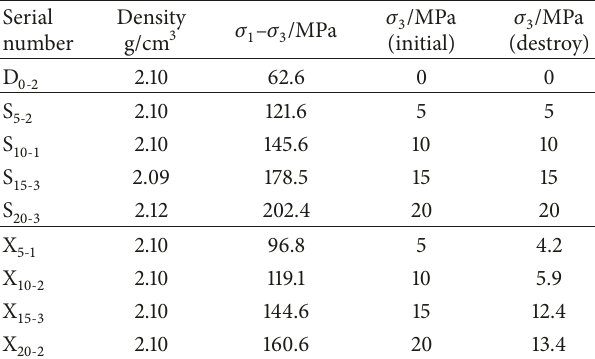
Table 1: Experiment results of rock specimens under different stress